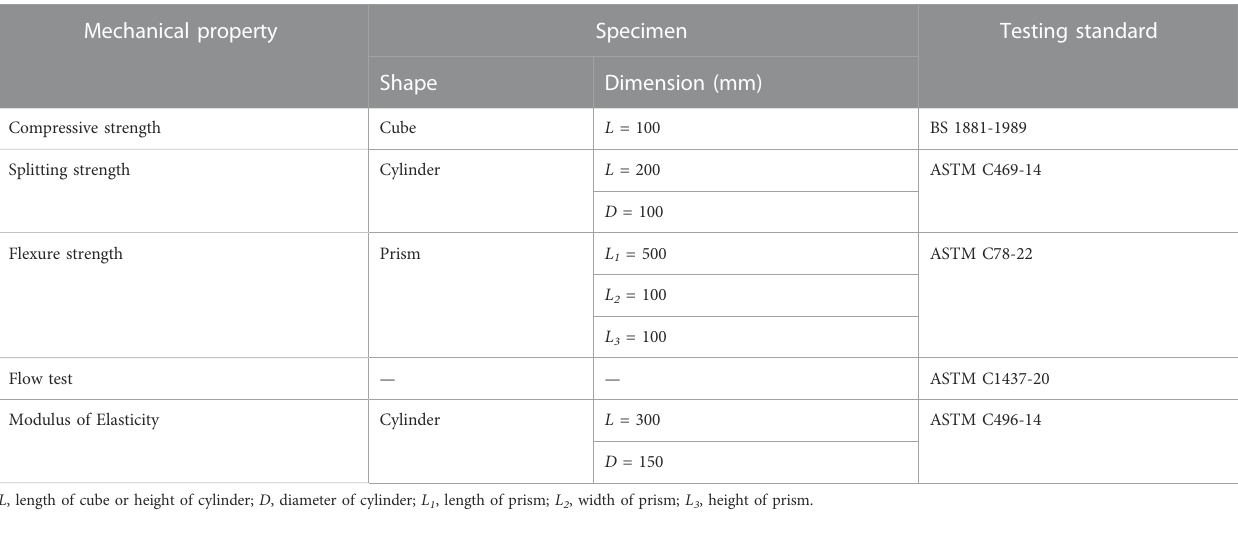
TABLE 5 Characterization tests performed on the mixtures.